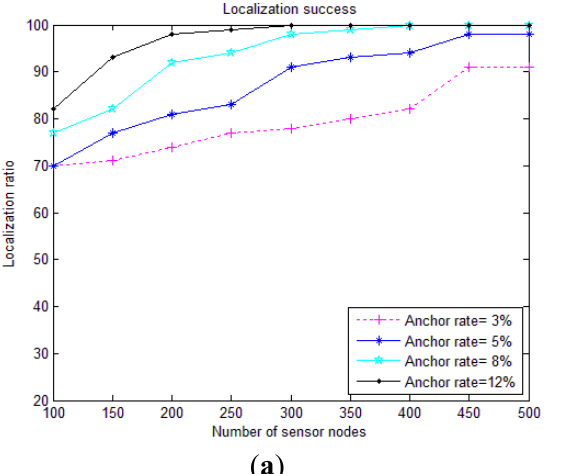
Figure 7. Average localization success. ( a ) Beacon nodes with random distribution; ( b ) Versus Grid deployment in water